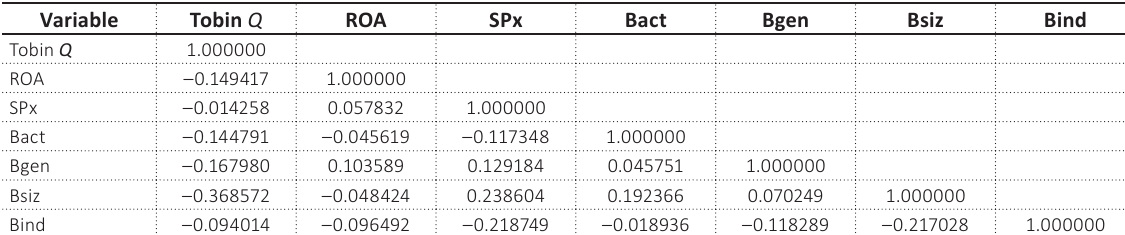
Table 3. Correlation